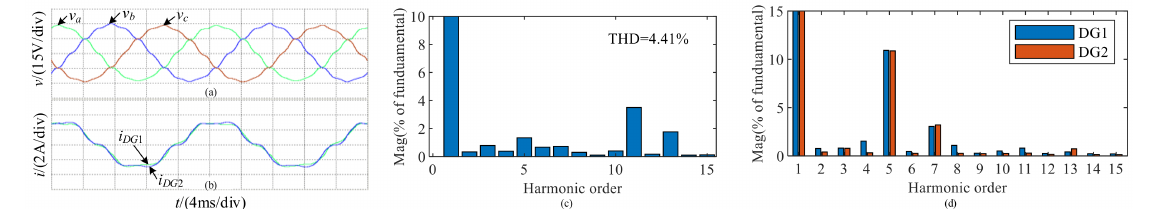
Figure 14. The experimental results of the method proposed under the non-linear load connected to the PCC: ( a ) PCC voltage; ( b ) Phase A output current of DGs; ( c ) FFT analysis of phase A voltage of PCC; ( d ) FFT analysis of phase A output current of